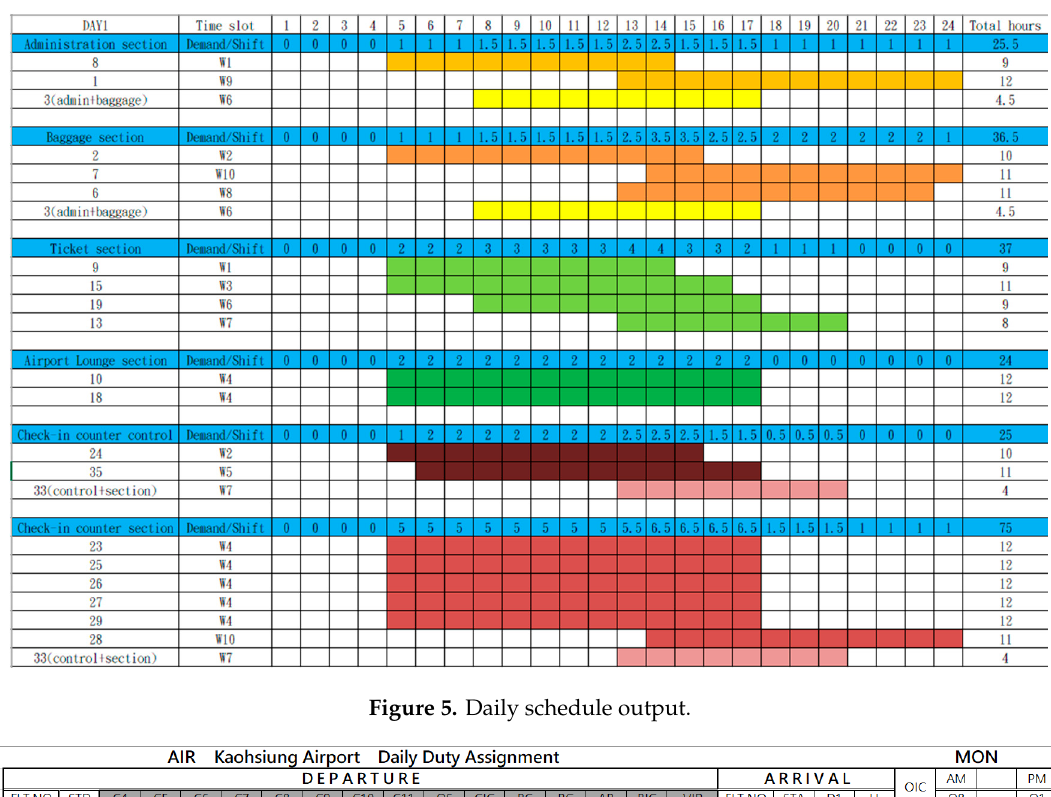
Figure 4. Monthly schedule output.